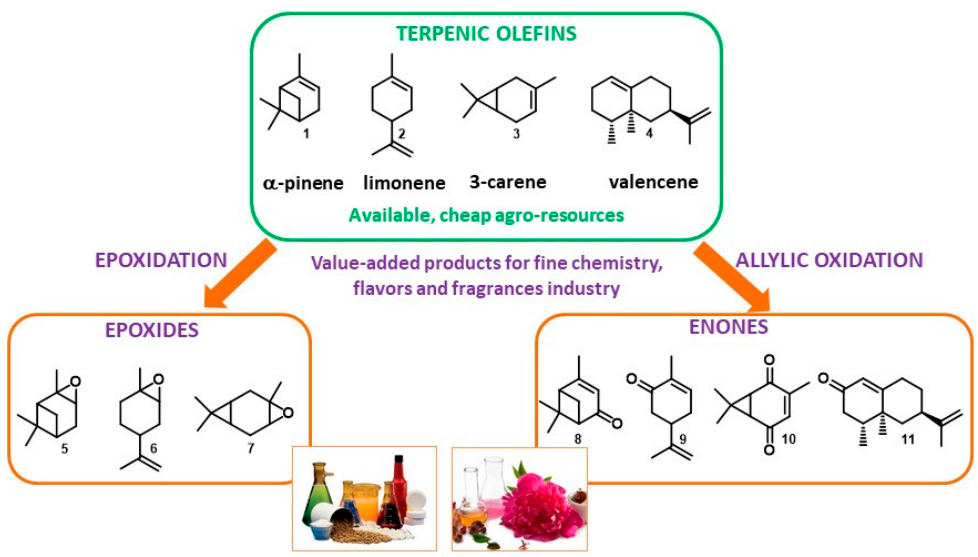
Figure 1. Oxyfunctionalization of terpenic olefins into value-added products.